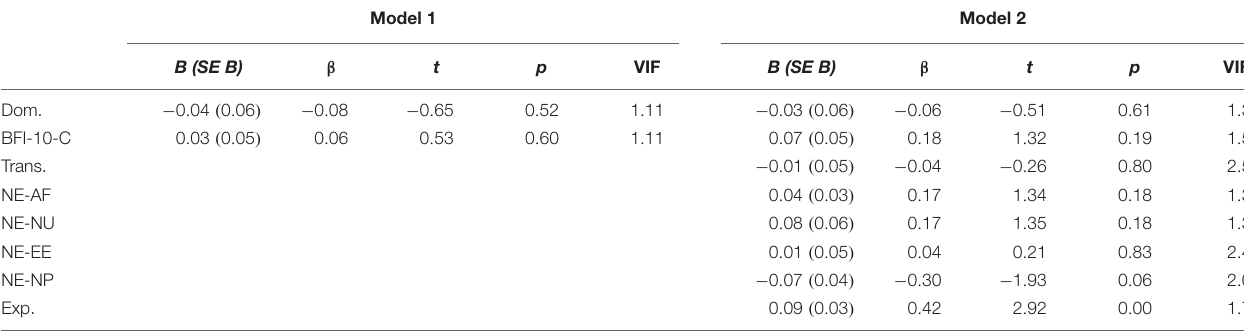
TABLE 5 | Hierarchical regression analysis predicting time spent on the anagram-solving task (log 10 ) for Study 2. Model